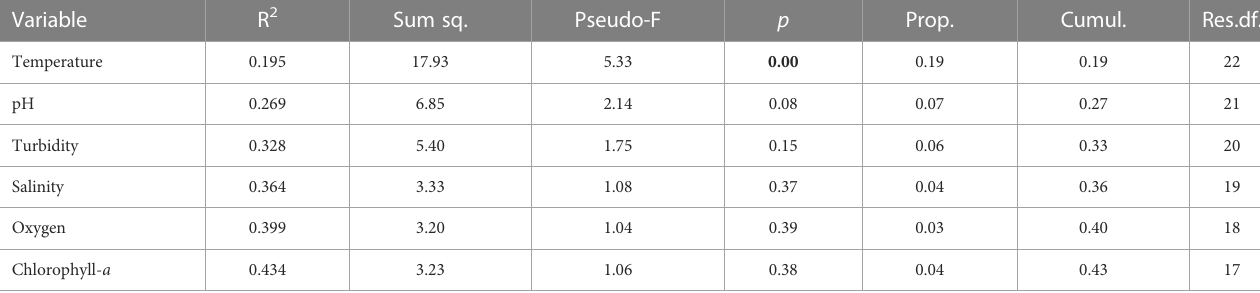
TABLE 4 Results of a distance-based linear model (DistLM) of the effect of environmental variables on coral metabolic parameters. Variable R 2 Sum sq. Pseudo-F p Prop. Cumul. Res.df.